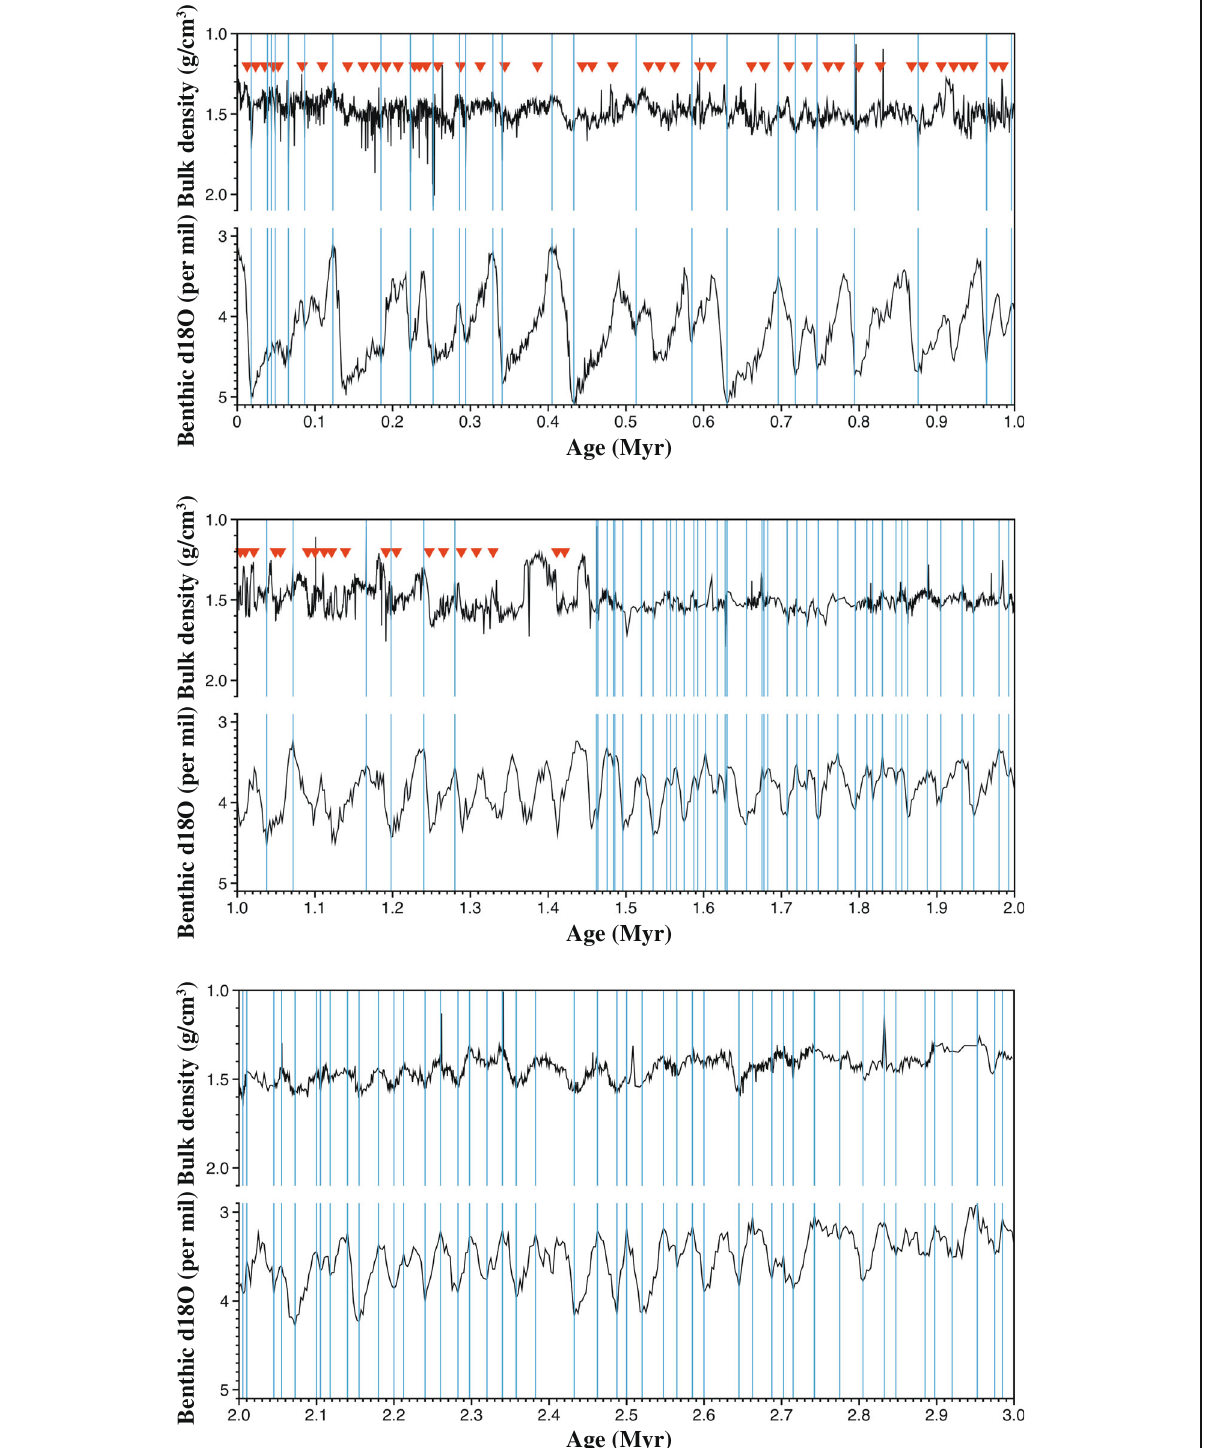
Fig. 2 Revised age model for U1423 based on projection of the “ U1424_LR04 tuned age ” (Tada et al. 2018) to site U1423 by the inter-site correlation of dark-light cycles for the last 1.5 Ma (red inverted triangles) and tuning of the GRA profile to the LR04 stack (vertical lines). Assuming that a high GRA represents glacial maxima, 118 horizons have been correlated to maxima of the oxygen isotope profile of LR04 for the last 2.975